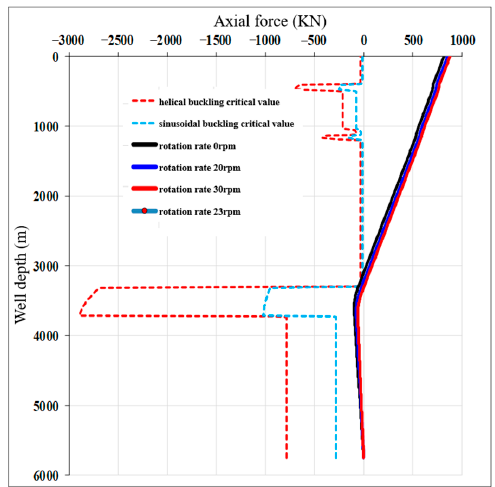
Figure 2. Distribution of casing axial force at different speeds under casing running conditions.